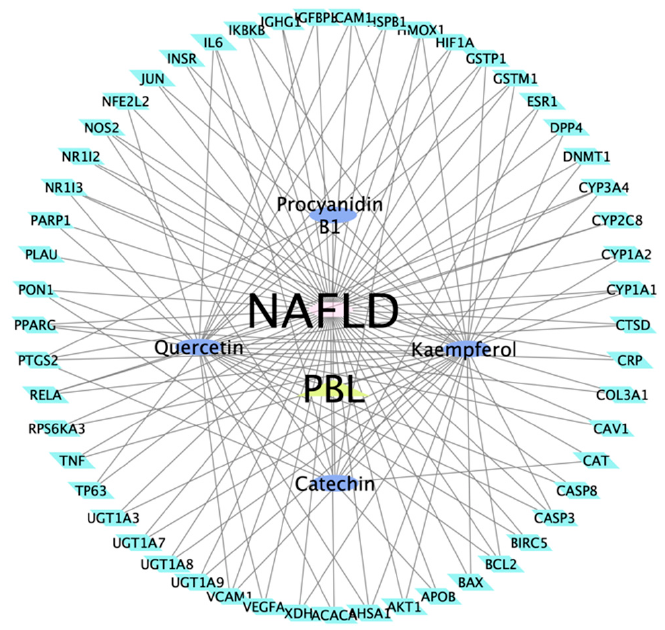
Figure 2. Herb-compound-target network of PBL.